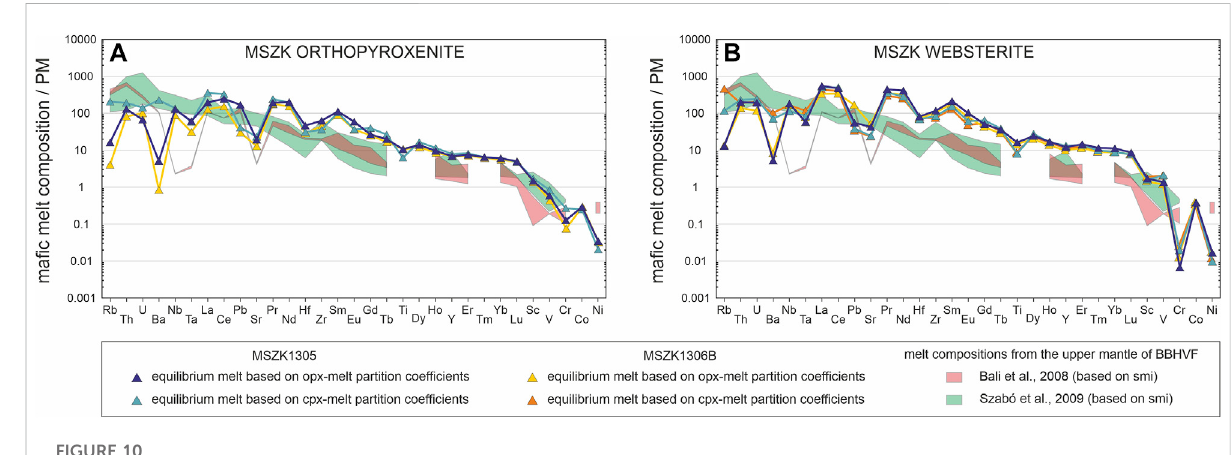
FIGURE 10 Estimated trace element composition of melt responsible for the formation of (A) orthopyroxenite and (B) websterite domains of composite xenoliths (MSZK1305; MSZK1306B). The silicate melt-orthopyroxene/clinopyroxene partition coef fi cients are taken from Ionov et al. (2002) and Adam and Green (2006). Primitive mantle (PM) (McDonough and Sun, 1995) normalized trace element distributions are compared to trace element compositions of melt modelled from Bakony-Balaton Highland Volcanic Field (BBHVF) xenoliths (Bali et al., 2008; Szabó et al., 2009). Abbreviations: opx – orthopyroxene; cpx – clinopyroxene; smi – silicate melt inclusion; mp – melt